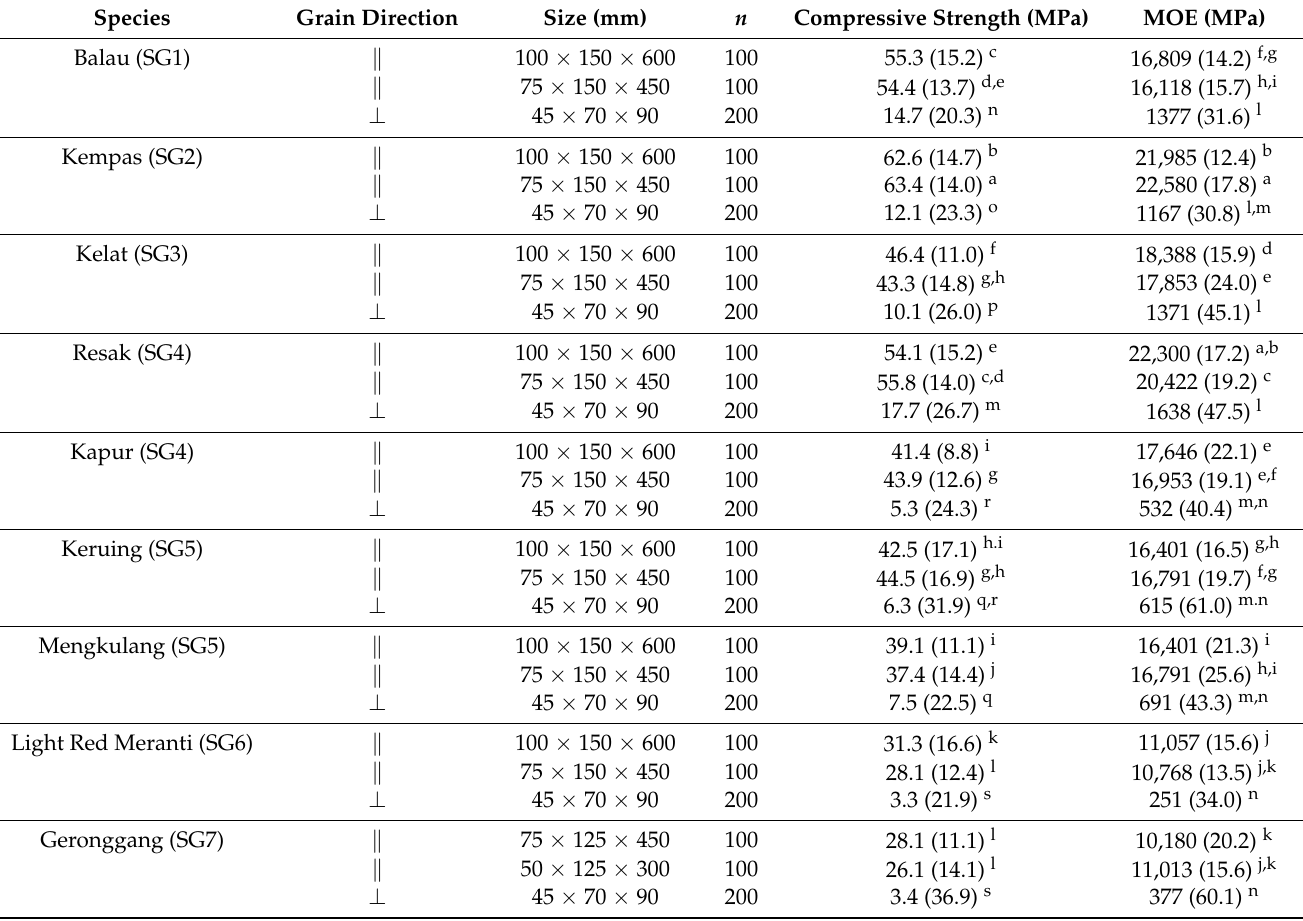
Table 2. Compressive strength properties at 12% moisture content of selected Malaysian tropical hardwood timber with different sizes loaded under different grain